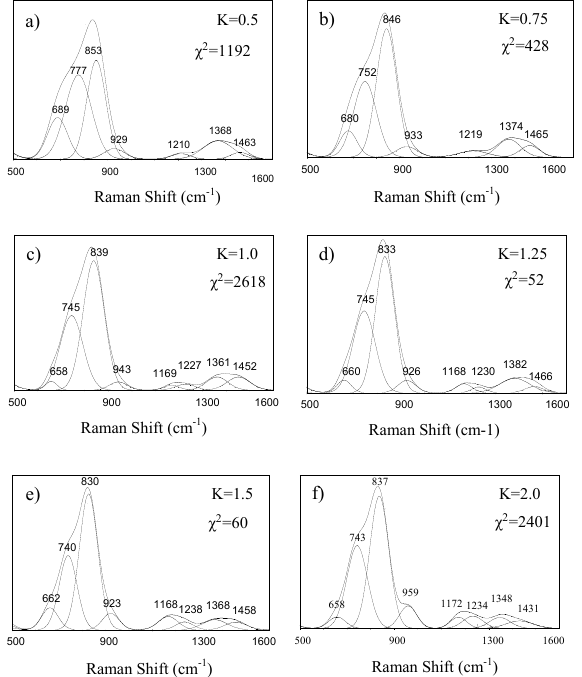
Figure 6. Deconvoluted results of Raman spectra for sam- ples with different K.